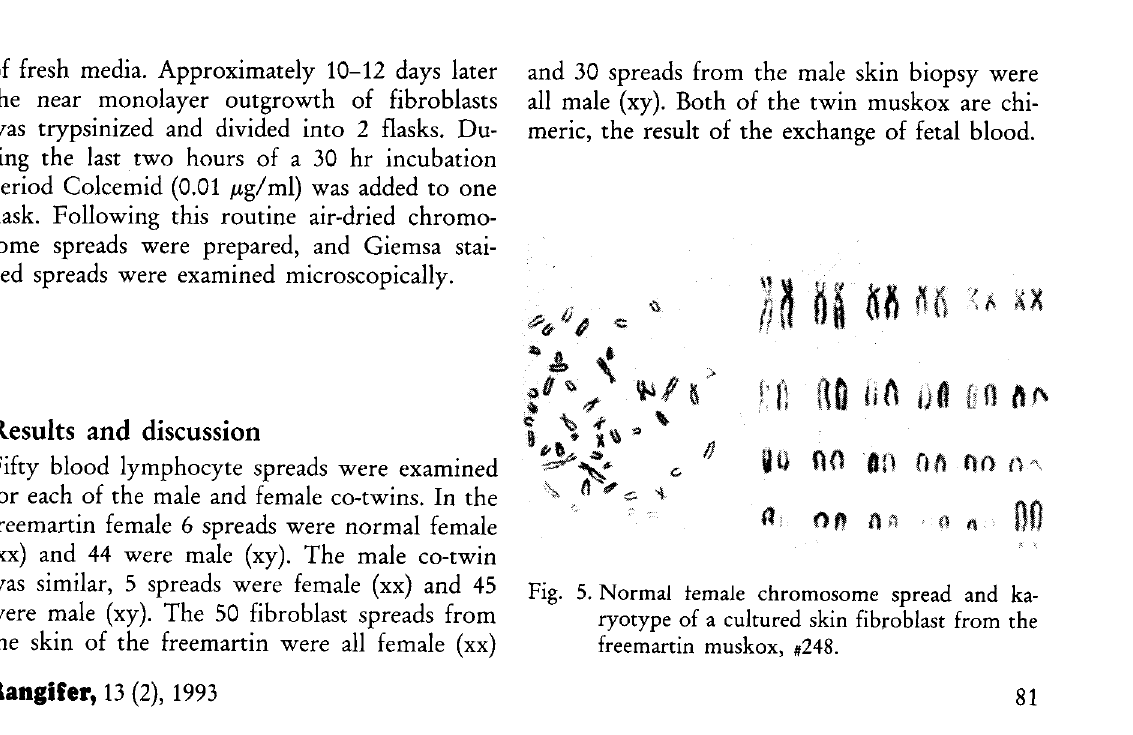
type of a cultured blood lymphocyte from the freemartin muskox, #248. The Y chromo some is identified by the arrow.